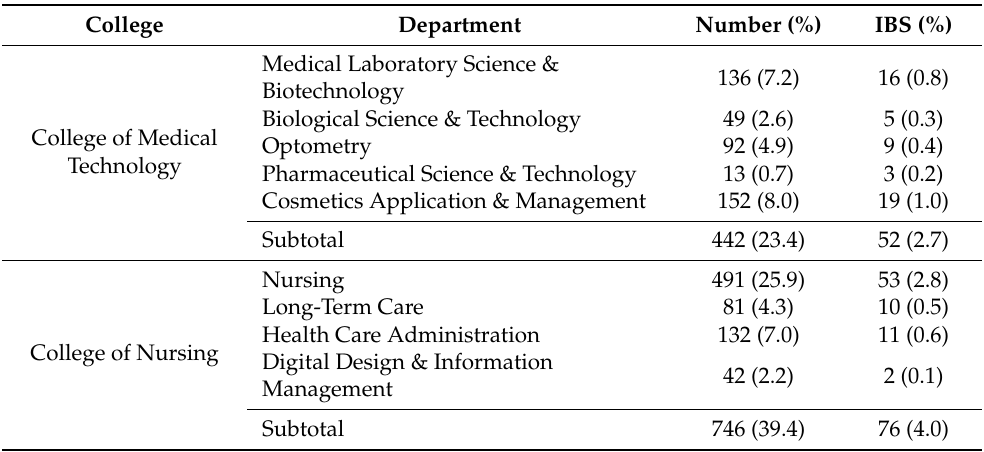
Table 1. The distribution of irritable bowel syndrome for female students among three colleges (N =